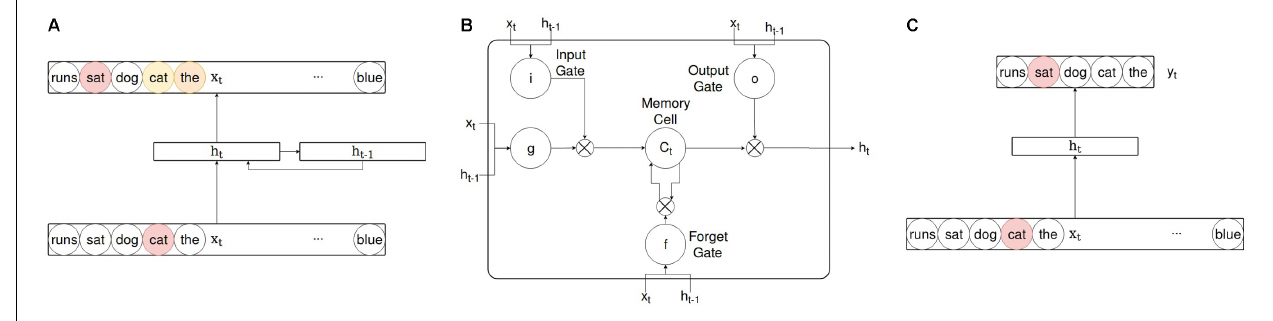
FIGURE 1 | A simple comparison of model architectures showing the Simple Recurrent Network (A) , a single Long Short-term Memory (LSTM) unit (B) , and Word2Vec’s Skip-gram (C) . Note that 1B depicts a single LSTM unit, rather than the full LSTM model. The complete LSTM architecture consists of three layers as in (A) but with LSTM units instead of conventional sigmoidal or hyperbolic tangent units at the hidden layer. Colors depict the level of activation from 0 to 1 (yellow to red). Skip-gram does not have the full vocabulary represented at the output layer as in (A) , as Skip-gram is typically trained using negative sampling, where the objective is to predict the correct answer amongst a small selection of “negative”